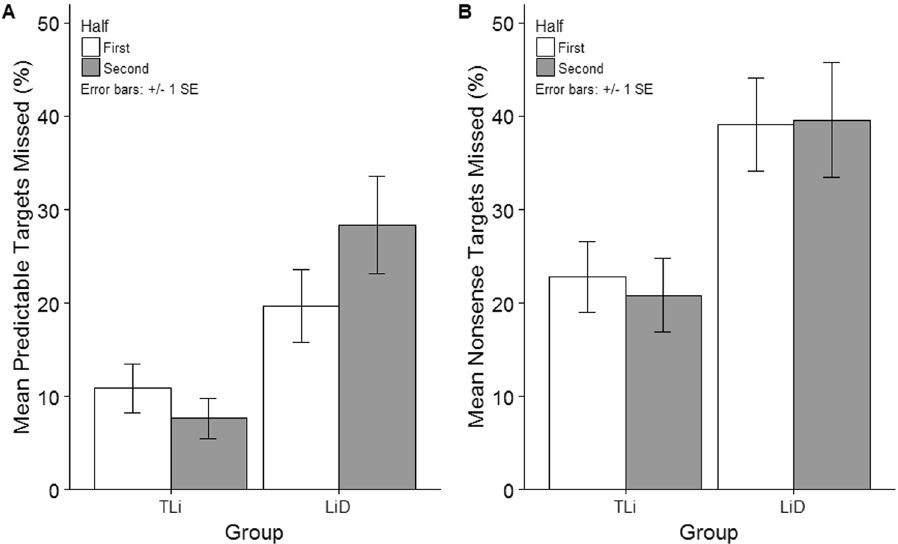
Figure 2. Effect of time-on-task according to Target Type [Predictable (panel A), Nonsense (panel B)], Half [1 st Half, 2 nd Half] × Group [TLi, LiD]. Error bars refer to standard errors.